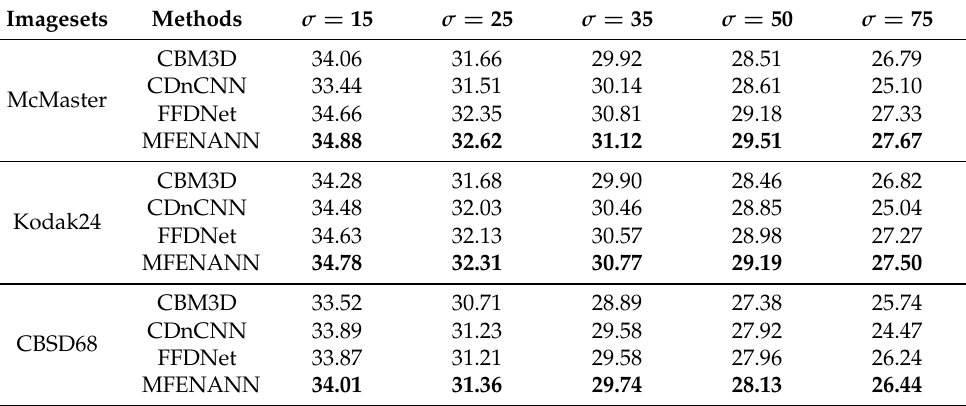
Table 8. Average PSNR (dB) values for images in image sets “McMaster”, “Kodak24” and “CBSD68” which were restored by several state-of-the-art methods at noise levels of 15, 25, 35, 50 and 75. The bold numbers are the largest ones at each corresponding noise